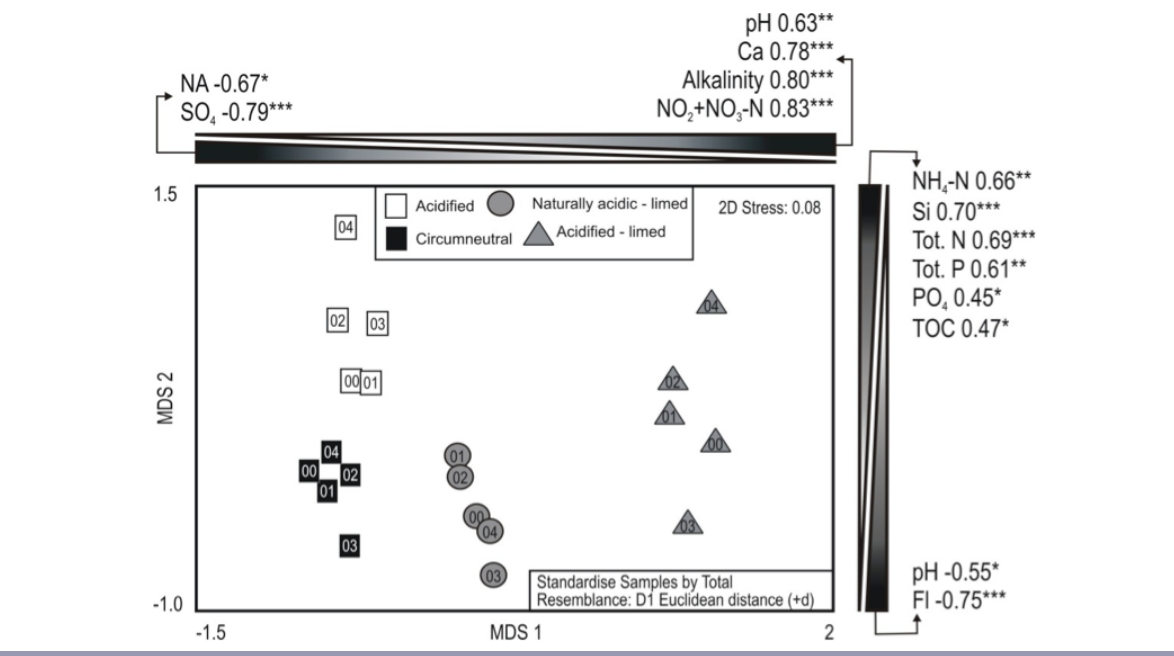
Fig. 2 . Nonmetric multidimensional scaling (MDS) ordinations showing similarities in water quality characteristics between lake types. Shown are also the variables that correlated with the MDS dimensions 1 and 2, and which explained gradients in water quality characteristics in the ordination. The strength of correlation is indicated by the Spearman rank